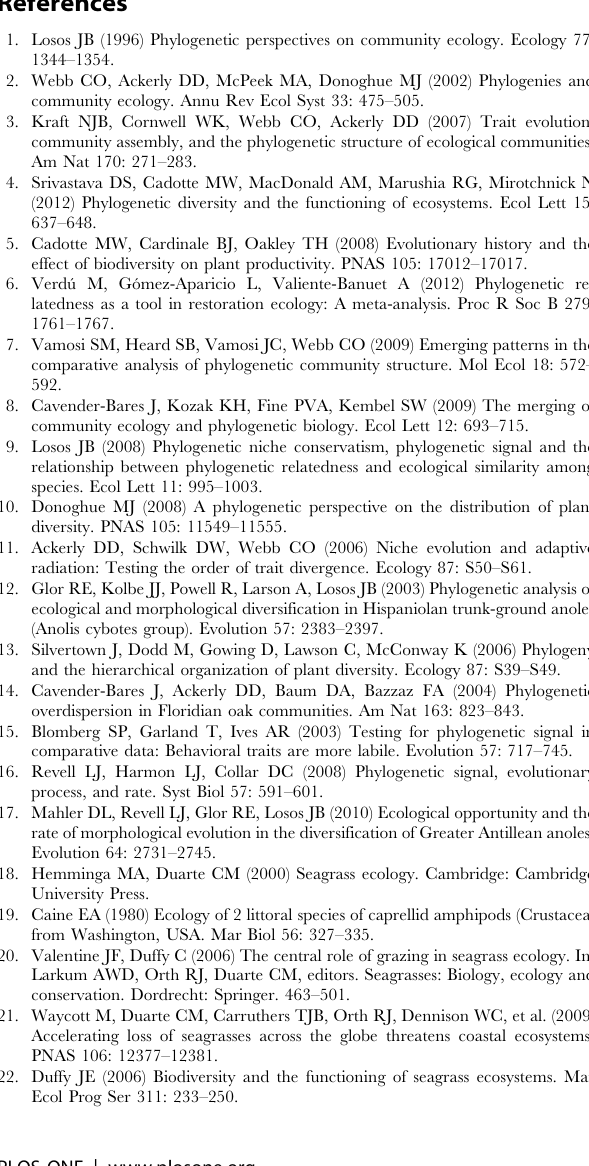
the number of species in the pool, but the relative amount of signal between traits is consistent (except for temperature tolerance when isopods are excluded). P-values , 0.05 are italicized, along with their corresponding K or l